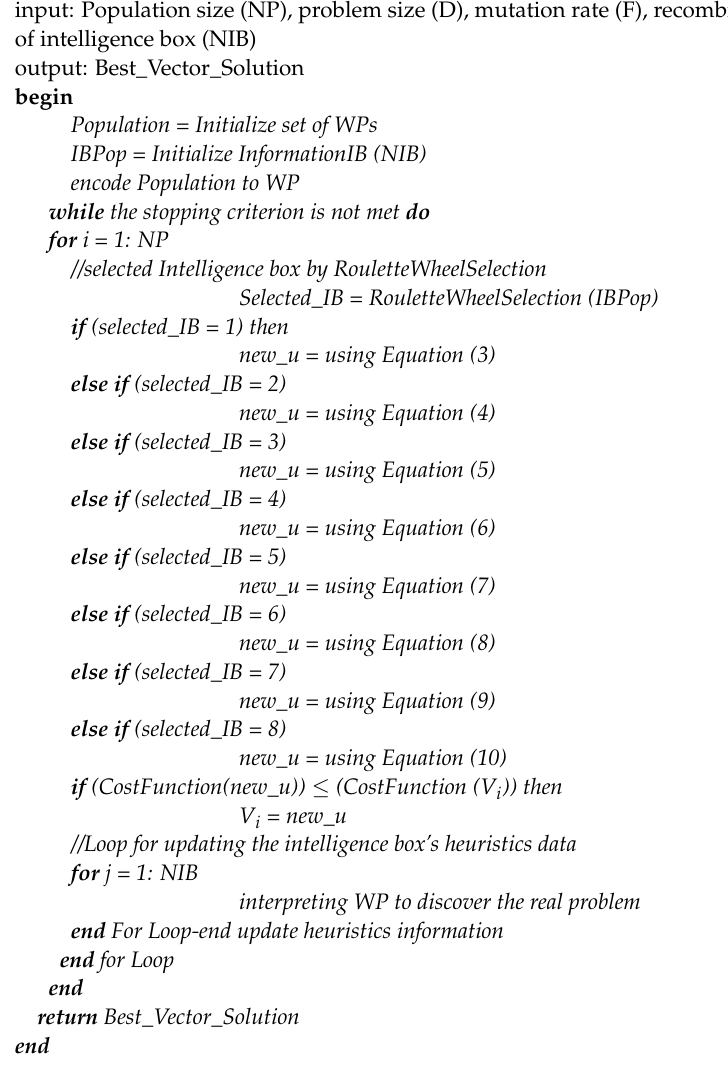
Algorithm 1: Artificial Multiple Intelligence System